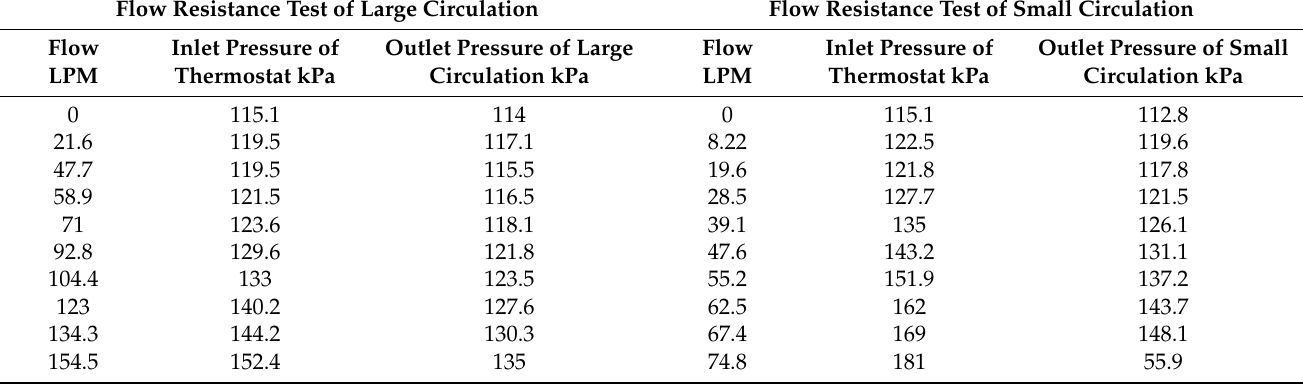
Table 2. Experimental data of resistance coefficient.